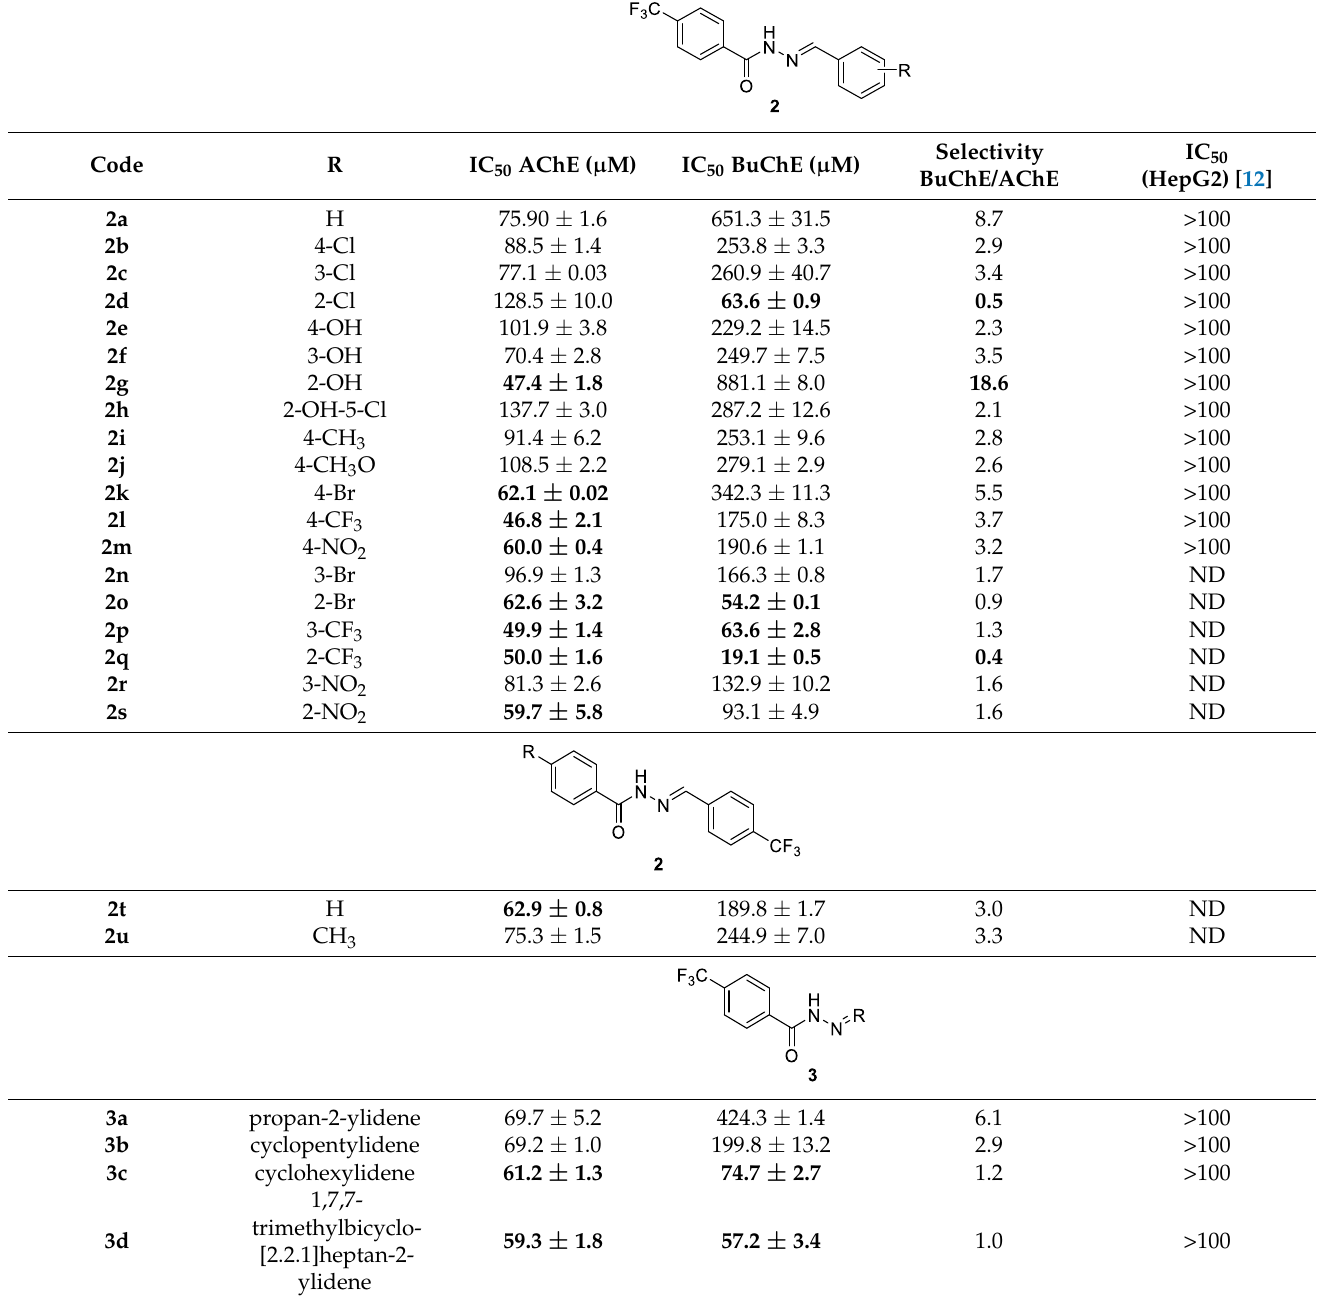
Table 1. Inhibition of AChE and BuChE, selectivity and toxicity data of 1 – 3 .